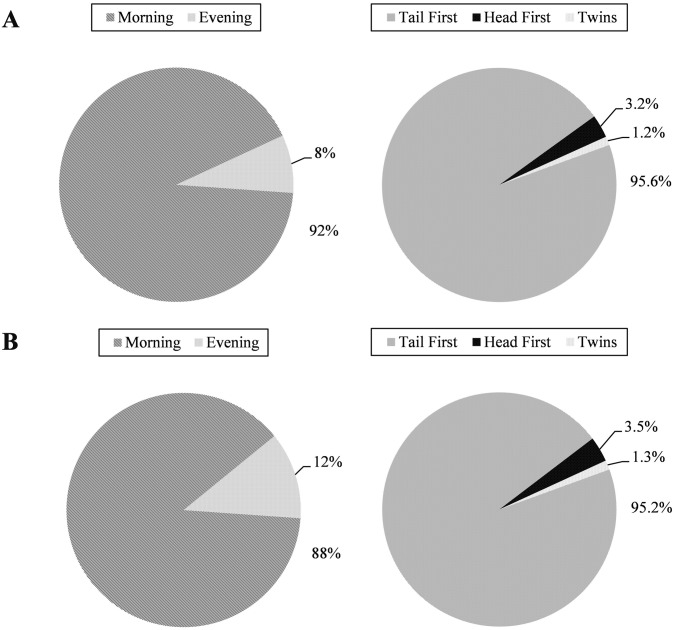
Frequency of parturition timing (left) and postures (right) in G. holbrooki at: (A) 25°C and (B) 23°C.